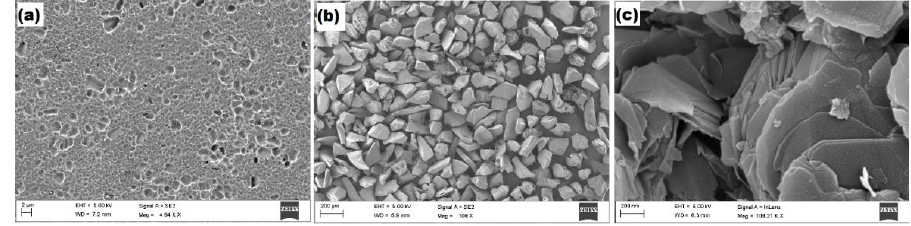
Figure 1. Scanning electron microscopy (SEM) micrographs of as-received ( a ) Al6061, ( b ) SiC powder, and ( c ) graphite powder.